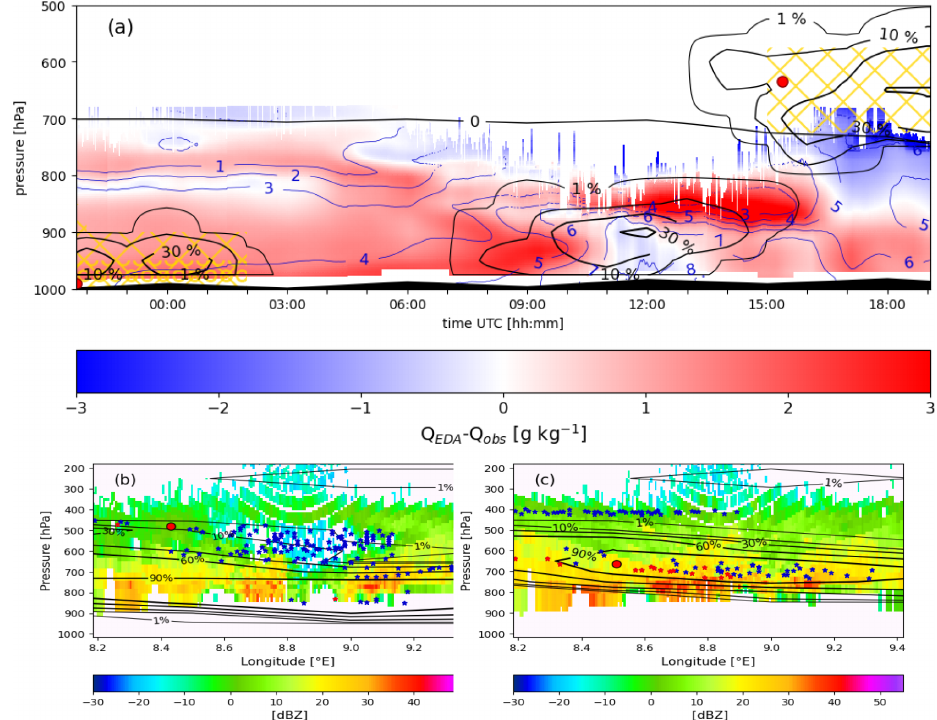
Figure 8. Time–height plots of measurements from (a) the water vapour lidar near Montpellier and (b) and (c) the Monte Lema radar. Panel (a) shows the difference of specific humidity between the EDA mean and the lidar observations (colours, in gkg − 1 ), lidar-observed specific humidity (blue contours, in gkg − 1 ), the EDA mean 0 ◦ C isotherm (thin black contour), WCB probability (thicker black contours for 1, 10, 30, 60 and 90%) and intersections of air parcels that were later sampled by the Falcon (yellow hatching, crosses for flight IOP2b and circles for IOP2c) from 21:44UTC on 13 October to 19:03UTC on 14 October 2012. The intersections of trajectories T1 and T2 are highlighted with a red dot. Panels (b) and (c) present vertical cross sections of radar reflectivity from the Monte Lema radar (colours, dBZ) at 46.15 ◦ N, which is 12km north of the radar; WCB probabilities (black contours, as above); and intersection points of Falcon-probed trajectories (blue) and Falcon-probed WCB trajectories (red) at (b) 23:40UTC on 14 October with Lagrangian matches with flight IOP2b and the intersection of T1 as a red dot and (c) 06:35UTC on 15 October 2012 with Lagrangian matches with flight IOP2c and T2 as a red